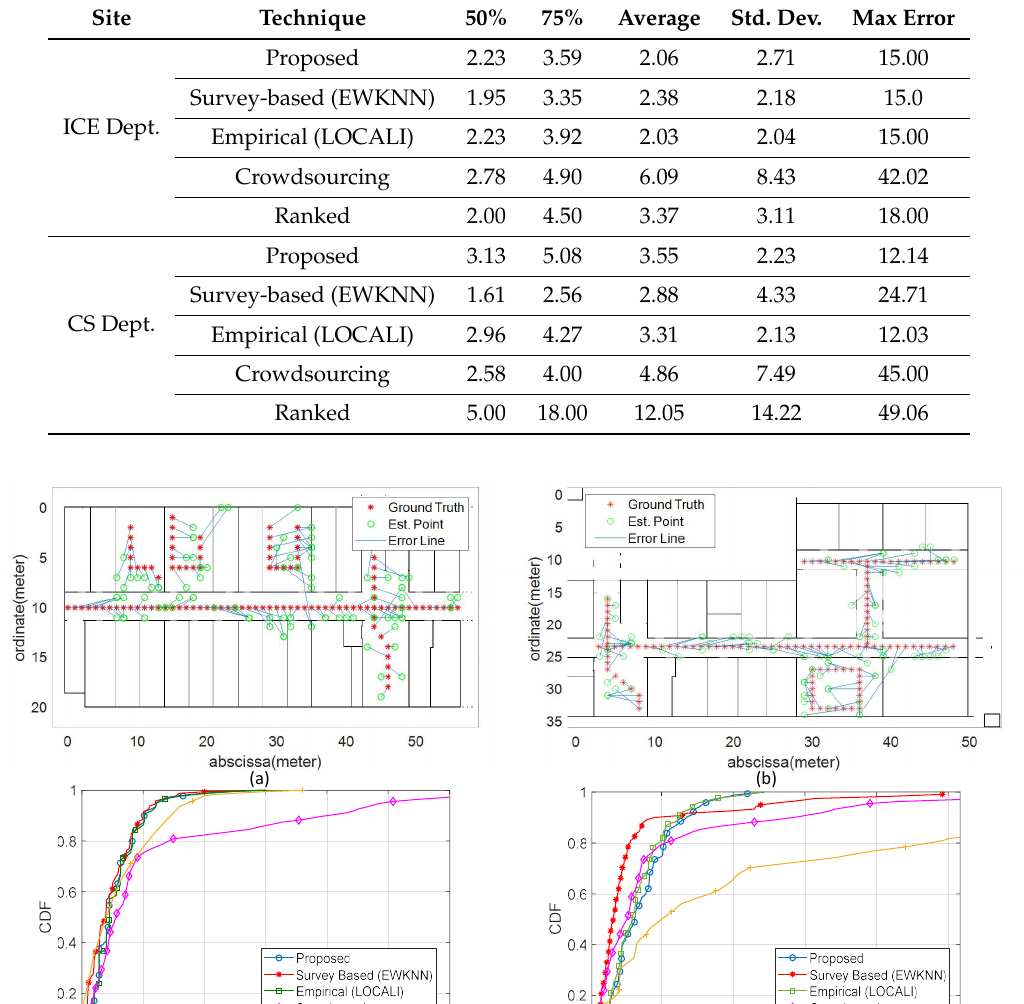
Table 4. Positioning accuracy statistics, Std. Dev.; Standard Deviation and Max Error; maximum error for proposed system compared to other techniques at both sites.